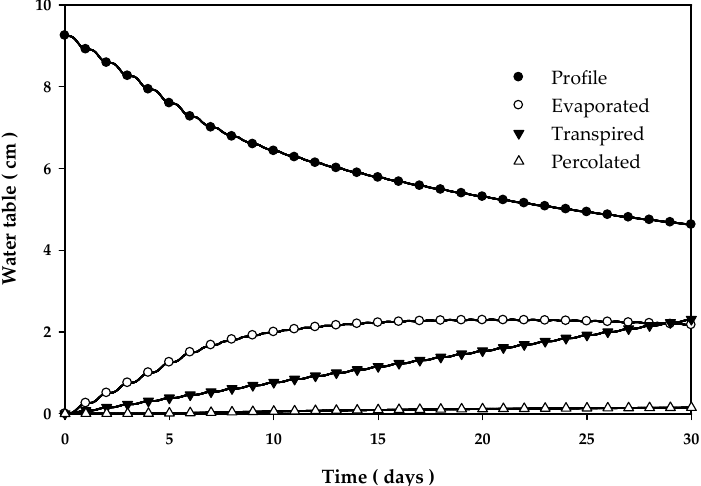
Figure 5. Accumulated water tables as a function of time in the soil control profile, evaporated, transpired, and percolated after irrigation in sandy loam soil in Montecillo, Mexico.